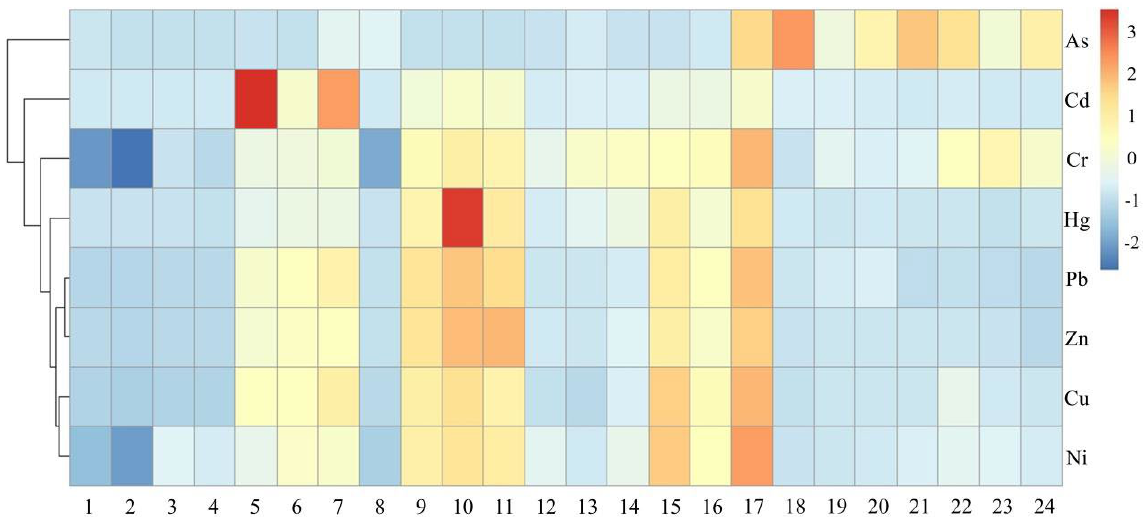
Figure 7. Cluster analysis heat map of heavy metals in sediments from the Huafei River.